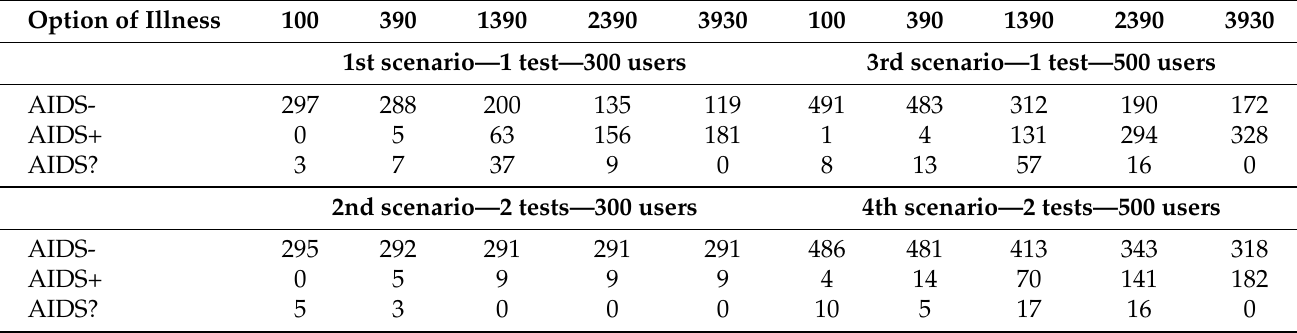
Table 8. Comparison between the four scenarios for a different number of weeks by considering the 3rd example with 0% fuzzy.